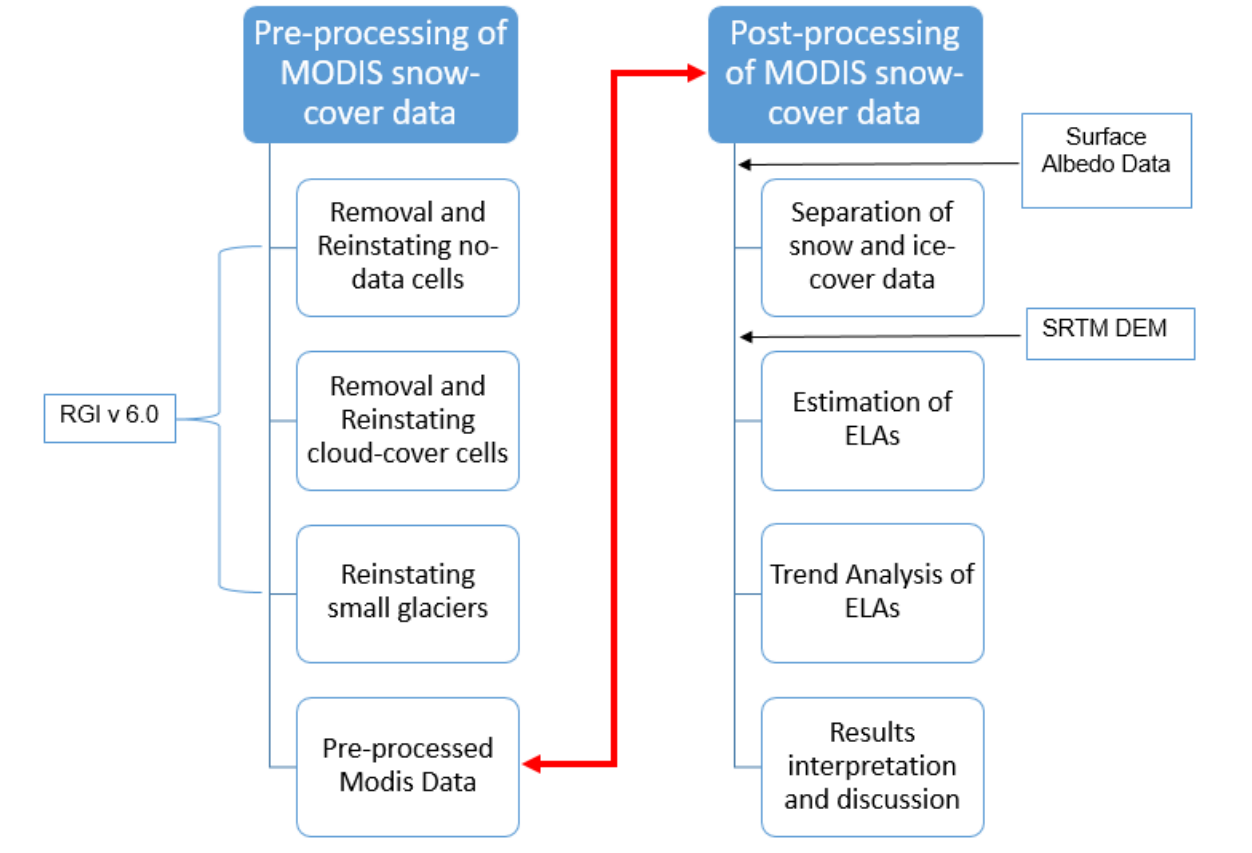
Figure 3. Schematic diagram of ELA estimation in the Hunza Basin.